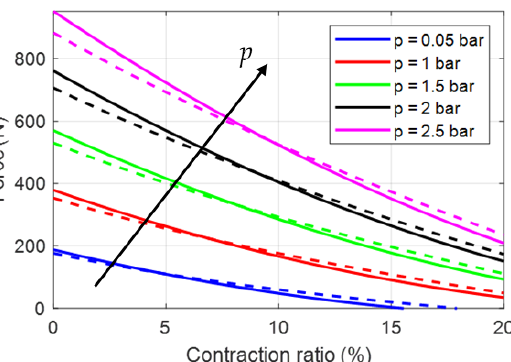
tion ratio and supply pressure. The curves obtained with the two models are similar and are shown in Figure 3, highlighting a good agreement between the two models.